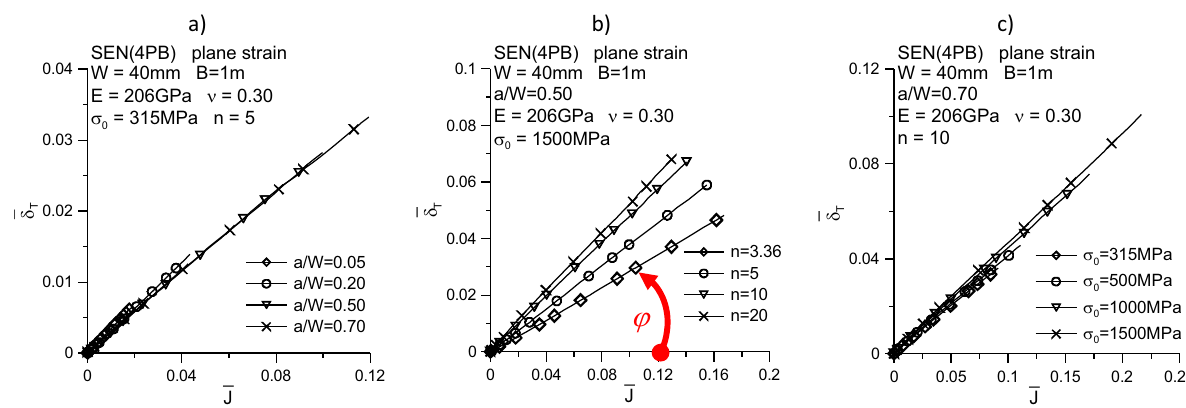
Figure 11: In fl uence of the relative crack length a / W ( a ) , the strain hardening exponent n ( b ) , law and the yield point σ 0 ( c ) on the δ